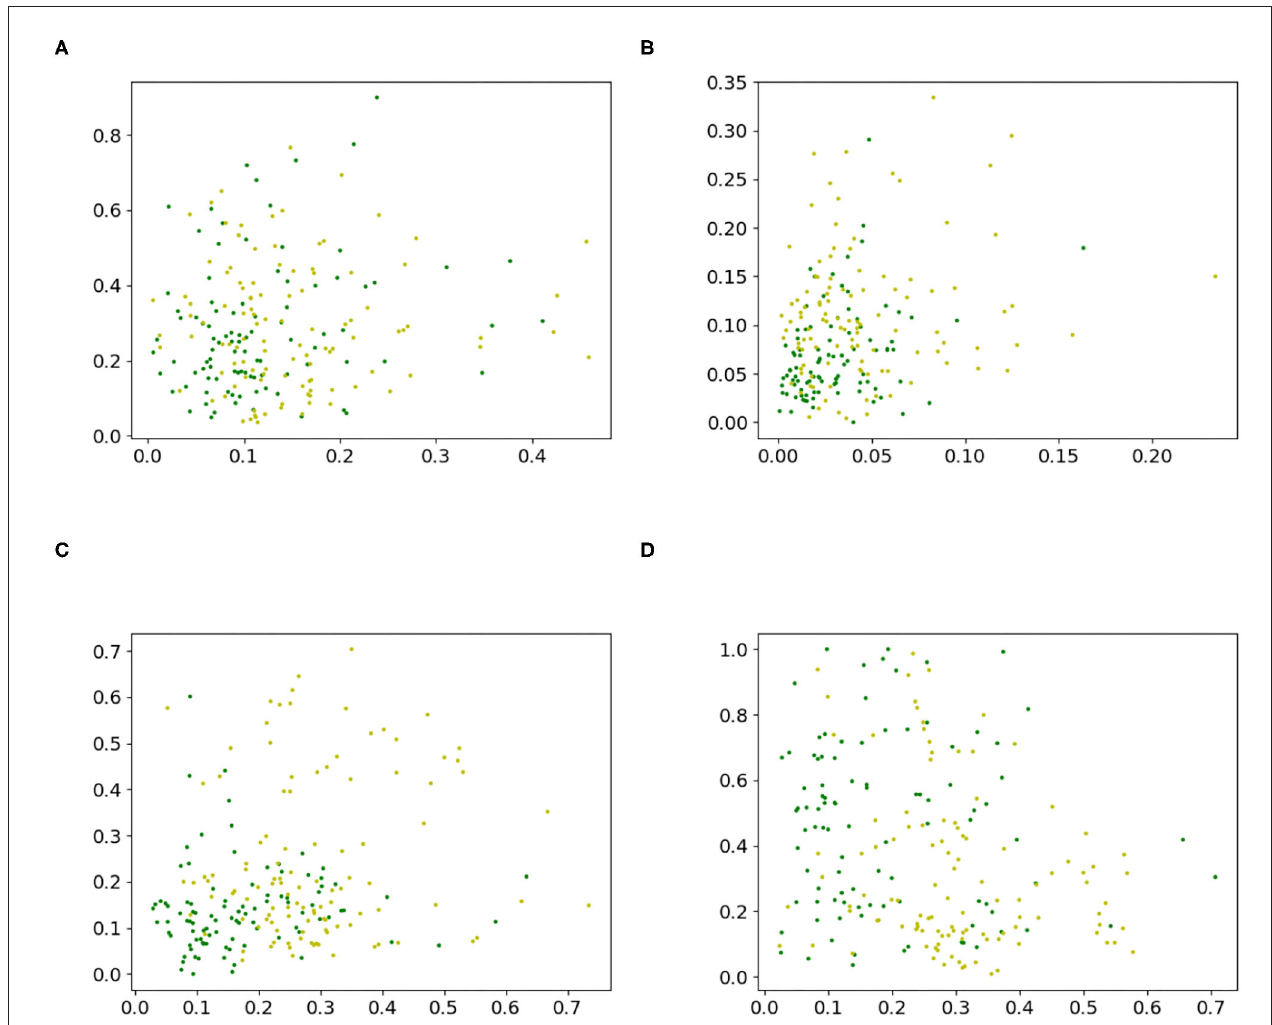
FIGURE 4 | 2-D datasets extracted from the sonar dataset to compare proposed iterative optimization with a grid search. (A) features 8 and 41, (B) features 2 and 48, (C) features 11 and 45, and (D) features 12 and 36.